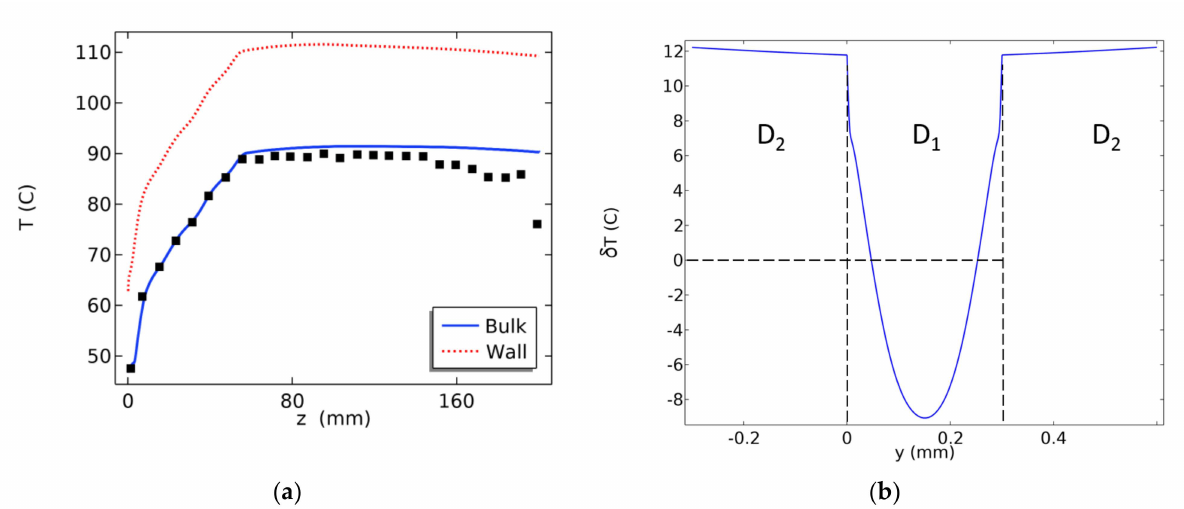
Figure 2. Longitudinal ( a ) and transverse ( b ) temperature profiles predicted by a 2D model of transfer processes during heat transfer under boiling conditions in the microchannel. δ T = T − T sat . D 1 –channel domain. D 2 –solid domain. Longitudinal section y = d h /2. Transverse section z = L/2. Points correspond to the experimentally measured temperature reported by D í az and Schmidt